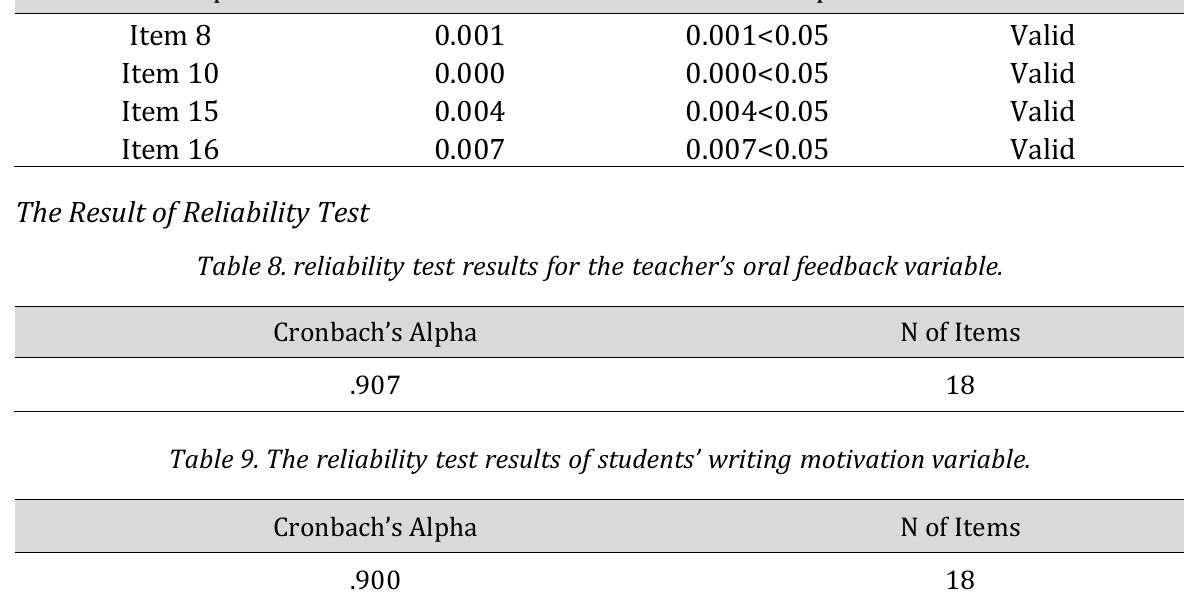
Table 7. validity test results of redistributed items for the students’ writing motivation Cronbach’s Alpha